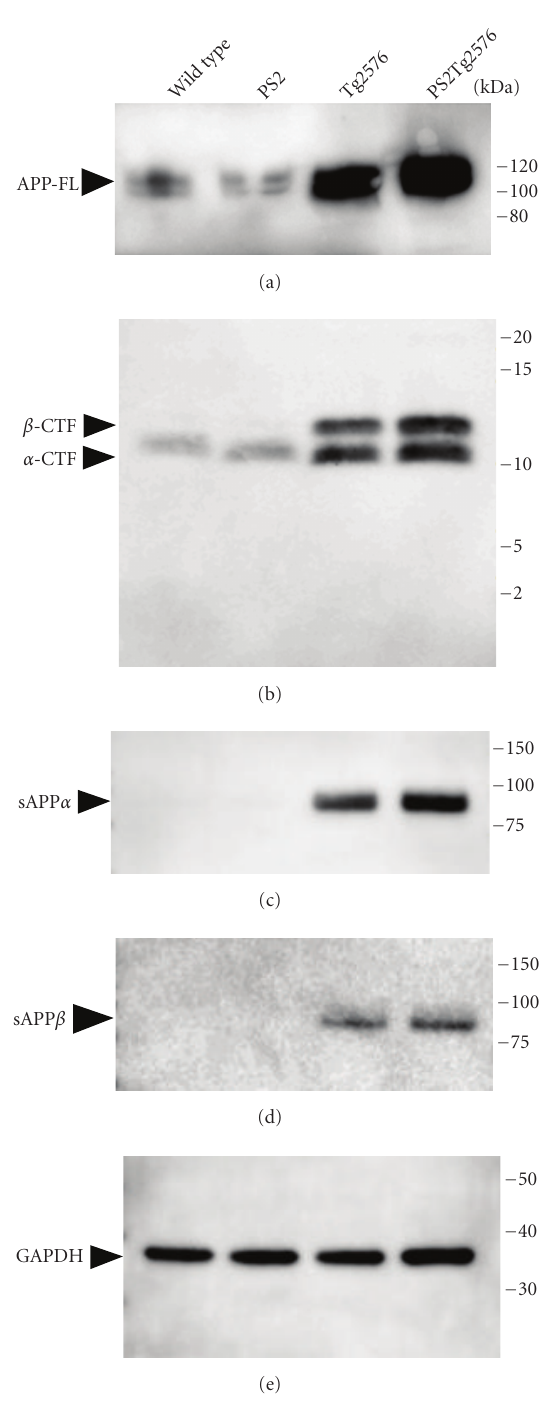
Figure 5: APP fragments were detected in mouse brains by Western blot analyses. Ten or twenty micrograms of whole brain proteins were prepared from each genotype at 10-11 months of age. (a) Rodent and human APP full-length (APP-FL) and (b) C- terminal fragments ( β - and α -CTF) were detected with the anti- APP C-terminus specific antibody. (c) The α -cleavage soluble APP (sAPP α ) band was observed with anti-sAPP α C-terminus specific antibody. (d) The β -cleavage soluble APP (sAPP β ) band appeared with anti-sAPP β C-terminus specific antibody. (e) Glyceraldehyde- 3-phosphate dehydrogenase (GAPDH) was used as an internal